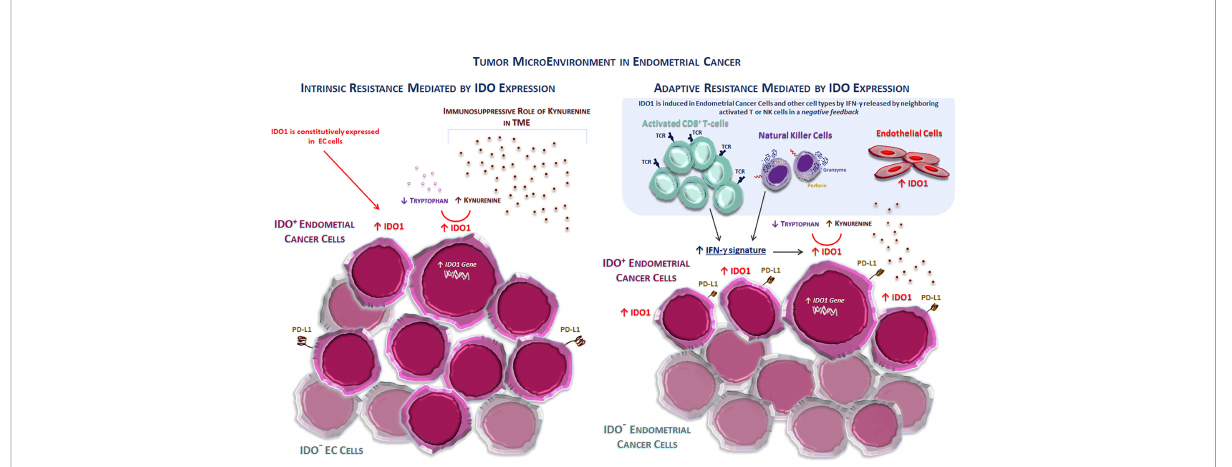
FIGURE 1 The tumor microenvironment in endometrial cancer. Two different mechanisms of immune resistance mediated by the IDO1 enzyme activity and expression in the TME in endometrial cancer. (Left) IDO1 is constitutively expressed in cancer cells (intrinsic or primary resistance) typically in non-in fl amed tumors, such as endometrial and ovarian cancers. This expression prevents the accumulation of the activated antitumor CD8 + T cells, thus inducing an immunosuppressive TME. (Right) IDO1 is induced in endometrial cells (IDO + EC cells) and other cell types (stromal and endothelial cells) by IFN- g released by neighboring activated T or NK cells in the context of a negative feedback loop (adaptive or acquired resistance). EC, endometrial cancer; IDO1, indolamine 2,3-dioxygenase 1; PD-L1, programmed death-ligand 1; TCR, T-cell receptor; TME, tumor